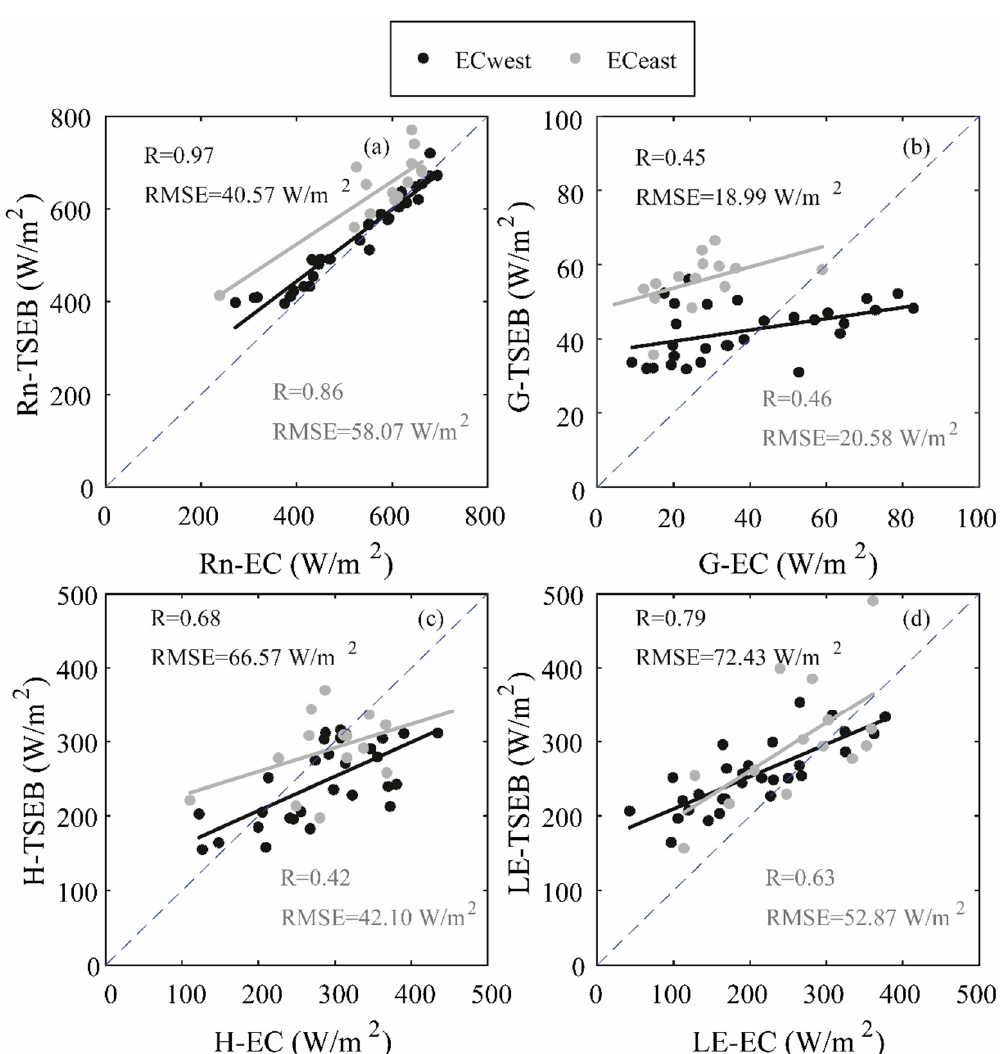
Figure 8. Net radiation ( a ), soil heat flux ( b ), sensible heat flux ( c ) and latent heat flux ( d ), scatterplots of the comparison between the Eddy covariance measurements and TSEB predictions based on Landsat products at satellite overpass time.